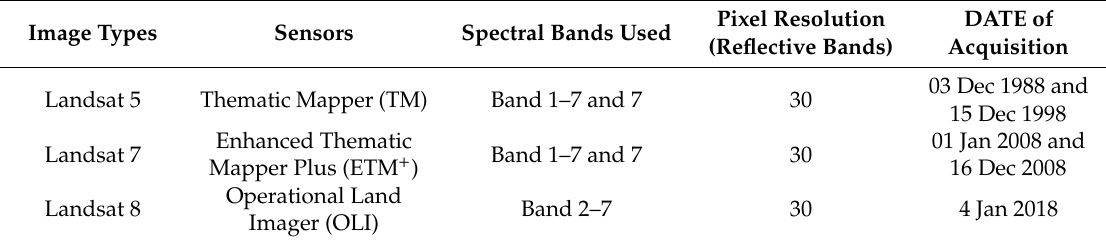
Table 3. Description of remote sensing Landsat images used in producing land use / land cover (LULC). thematic maps.